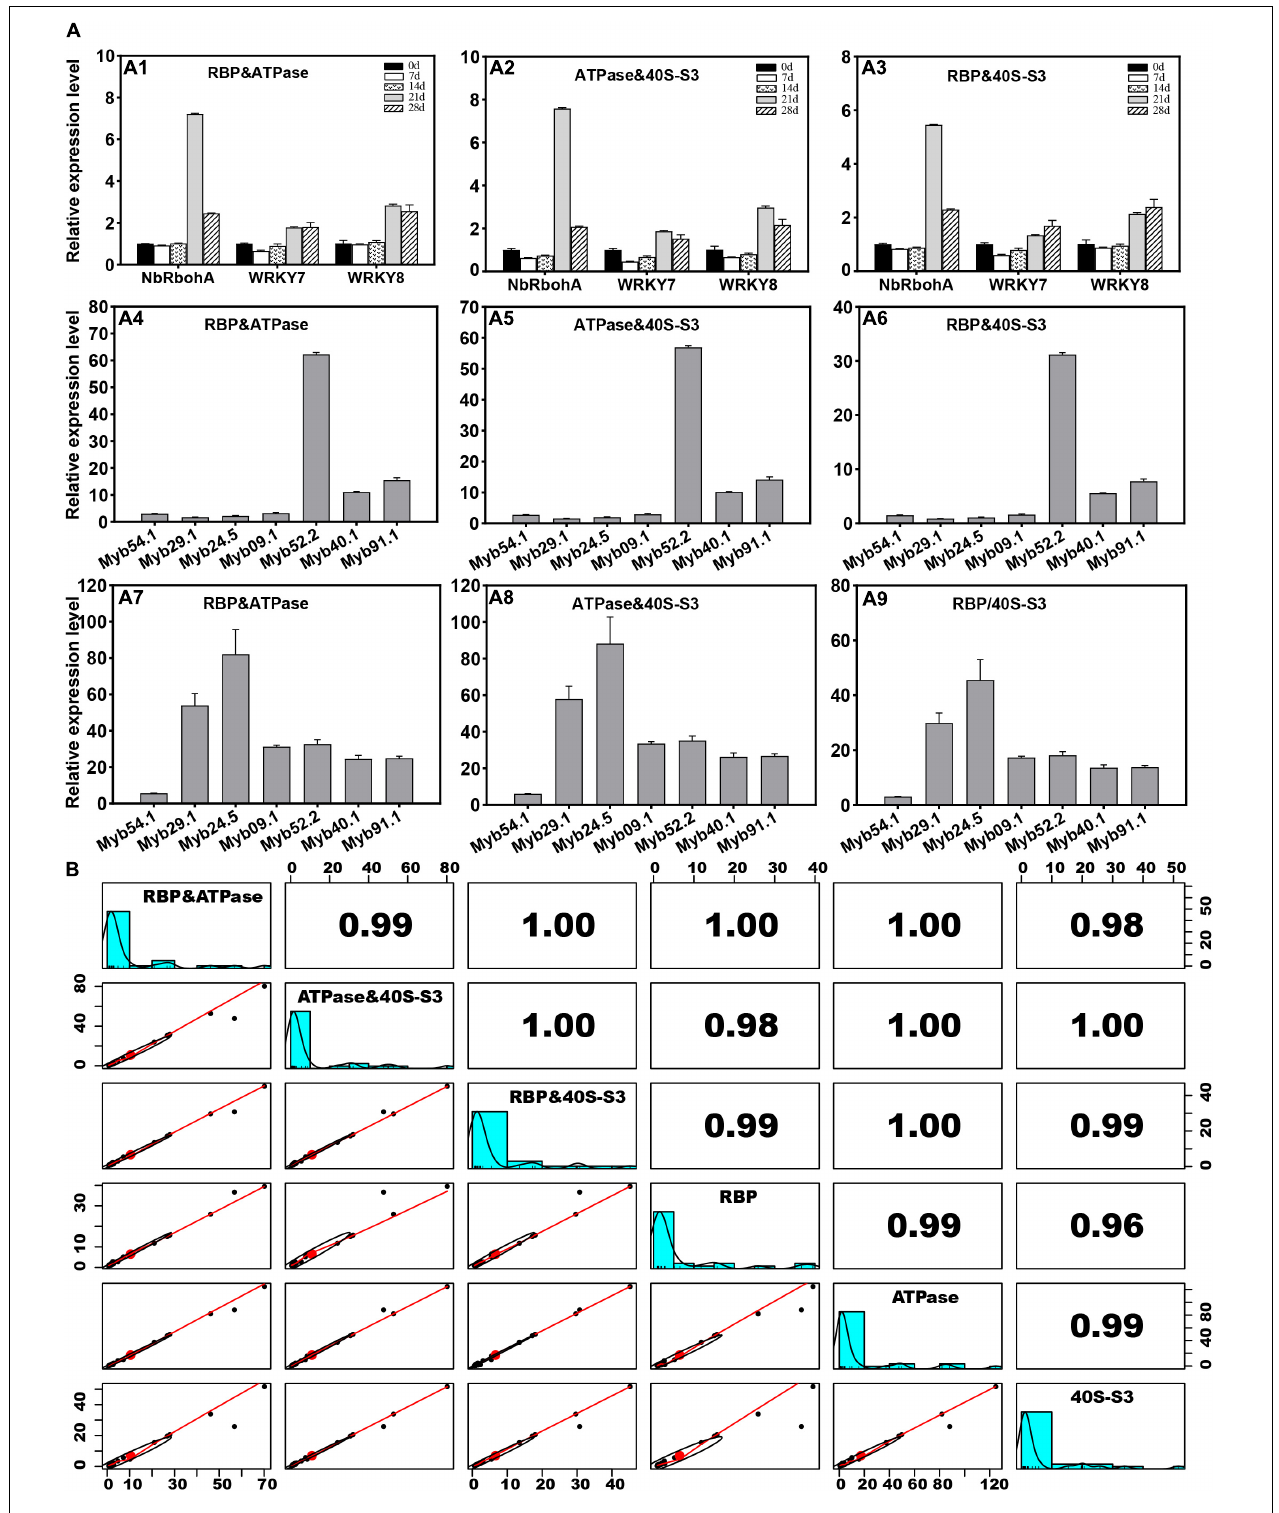
FIGURE 4 | Estimation of the stability of the double reference gene method. (A) The expression levels of PR and MYB genes are determined by reference gene pairs of RBP and ATPase , ATPase and 40S-S3 , or RBP and 40S-S3 . (B) Correlation analysis of expression levels determined by two and single reference genes.